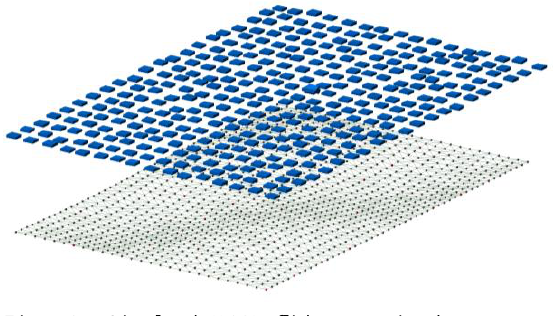
Figure 9. Simulated UAV flight scenario above area with 10 m undulation in Z-direction and a flying height of 50 m The simulation is based on a standard uncertainty for image measurements of 0.003 mm which is equivalent to a bit less Figure 10. Additional images for UAV-flight configurations 1 than a pixel for the Olympus camera. With respect to the to 3 (numbers in camera symbols indicate scenario) analyses of interior orientation and its estimation within a UAV flight scenario, three types of flight configurations are applied: The processing of the flight simulations follows a usual setup for the bundle adjustment in UAV-photogrammetry. In this case 1. The first scenario corresponds to a typical flight where all six homogeneous distributed control points are introduced to images are taken in the same relative orientation. define the datum. Their standard deviations are set to values of 2. The second configuration includes additional images 15 mm for X- and Y- and 30 mm for Z- coordinates. This taken above the centre of the area by rotating the camera, follows expectable accuracies gained with GPS measurements. respectively consecutively changing the yaw angle of the UAV by +90° (see Figure 10). 1: 30m dom undulation, h = 50m scenario 1: 10m dom undulation, h = 50m deviation to deviation to deviation to deviation to result result result input input input input